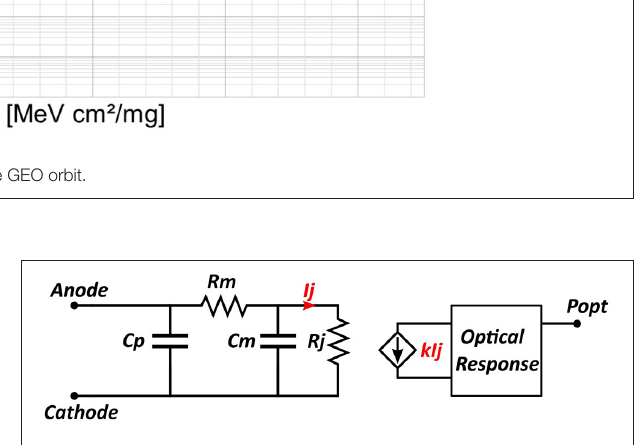
FIGURE 6 | VCSEL equivalent